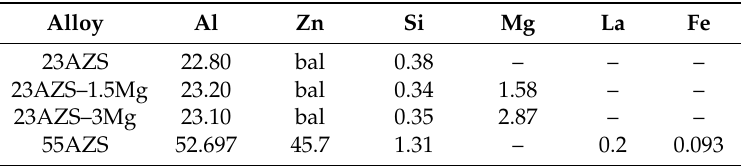
Table 1. Chemical composition of the alloys (wt %).